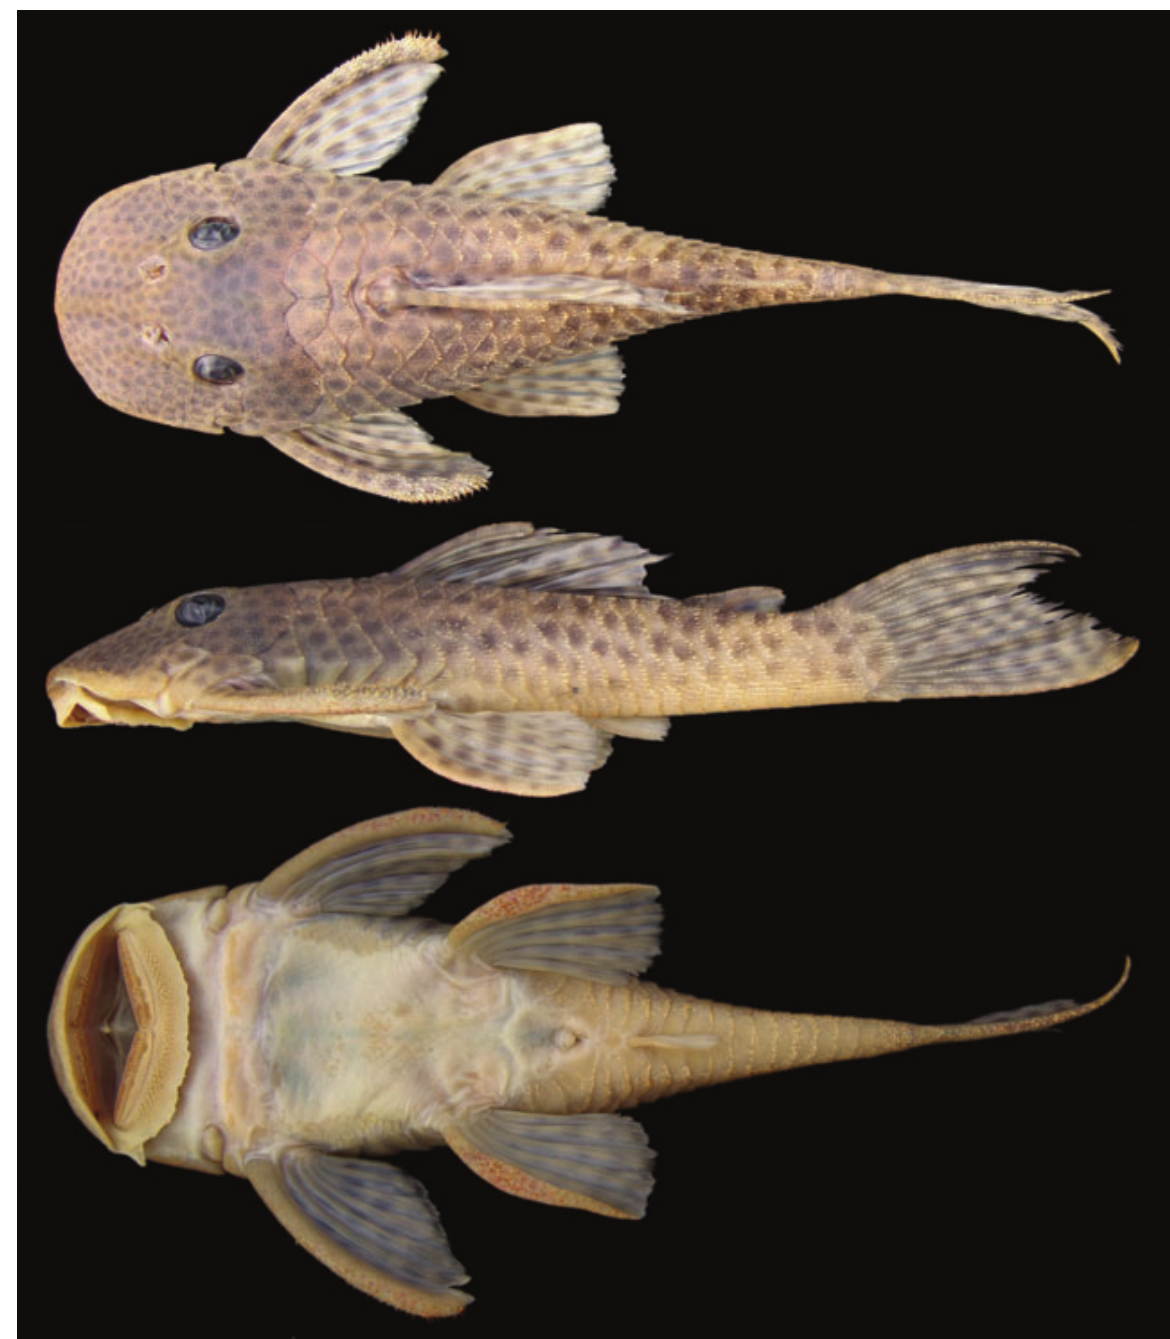
Fig. 7. Hypostomus mutucae , NUP 6641, 109.2 mm SL: Brazil, Mato Grosso, rio Paraguay basin, rio